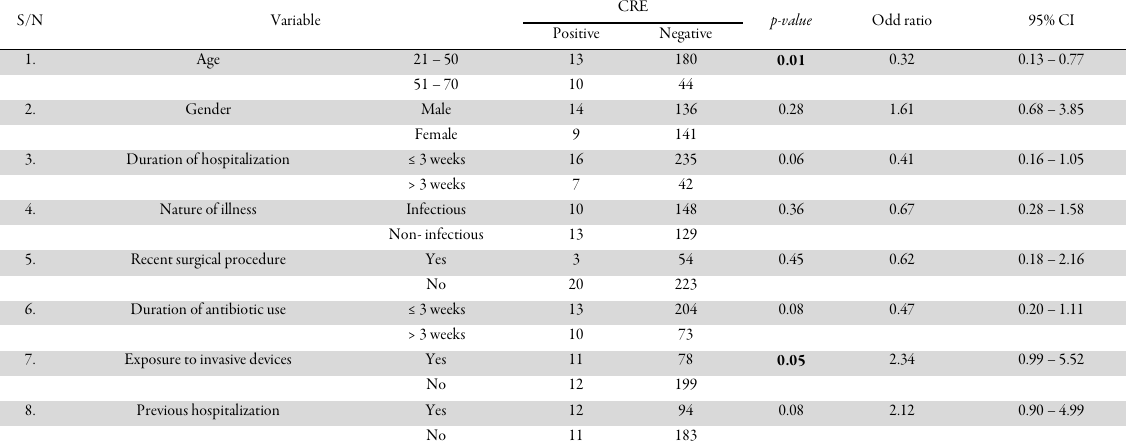
Table 4. Univariate analysis of the risk factors in association with CRE